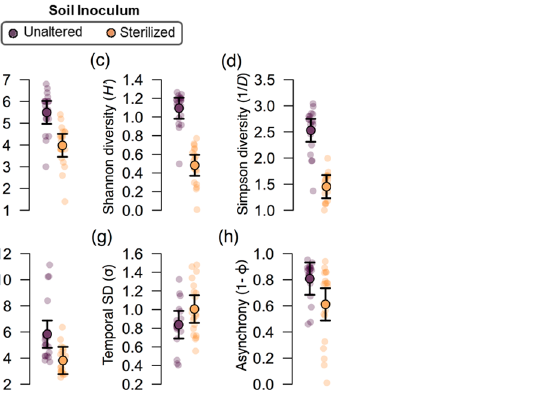
Fig 2. Temporal mean of plant community characteristics when inoculated with the sterilized and unaltered soil inoculum. Means with 95% confidence intervals for the pair-wise difference between the unaltered and sterilized soil community treatments are shown for (a) NAP, (b) realized plant species richness, (c) Shannon diversity, (d) inverse Simpson diversity, (e) evenness, (f) temporal stability in NAP, (g) asynchrony among plant species, and (h) the temporal standard deviation of NAP of plant communities when inoculated with unaltered soil or (dark points) or sterilized (light points) soil. Lightly shaded individual points are values for individual microcosms.